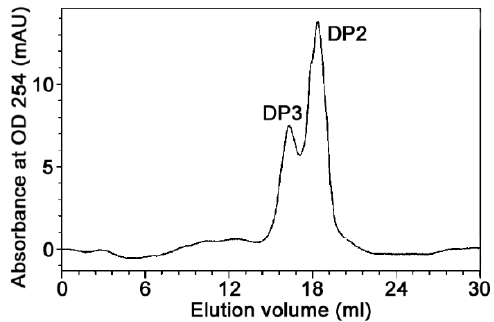
Figure 6. High performance liquid chromatography (HPLC) analysis of the end product of